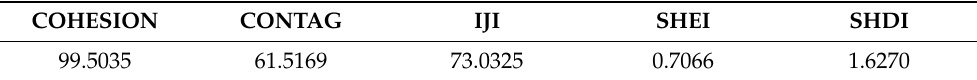
Table 6. Landscape pattern characteristics index of the national park.